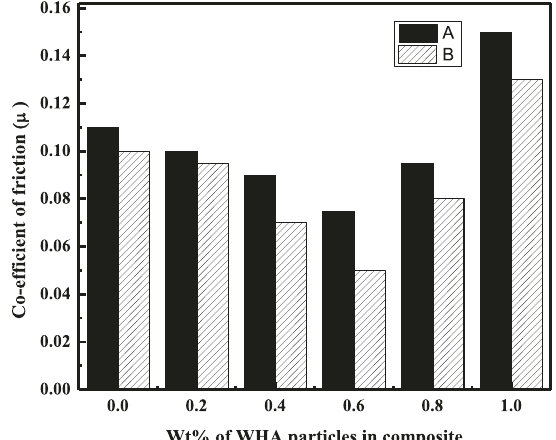
Fig. 9 Coef fi cient of friction of C m C during wear experiment con- ducted at 2 N applied load and 300 m sliding distance at room tem- perature in A dry and B wet condition